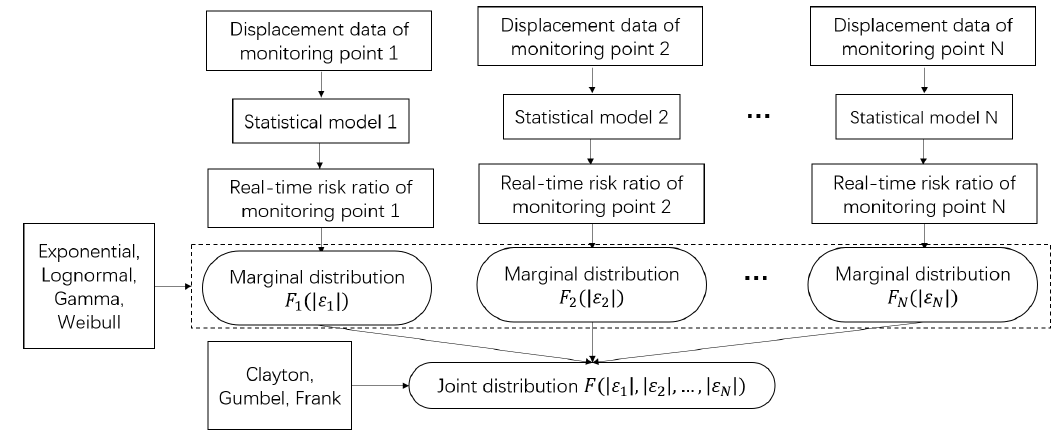
Figure 3. Flowchart of the proposed method.